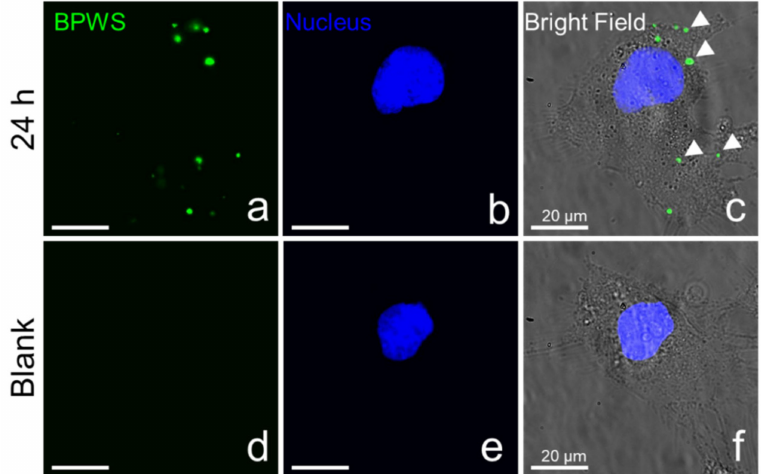
Figure 6. Fluorescence images of cancer cell permeability and intracellular uptake from the ( a ) NHS-Fluorescein (FITC) fluorescence signal, ( b ) 4 (cid:48) ,6-diamidino-2-phenylindole (DAPI) fluorescence signal, and ( c ) bright field merged image from FITC labeled biphenyl wrinkled mesoporous silica (FITC-BPWS) treated cells. Images ( d ) FITC fluorescence signal, ( e ) DAPI fluorescence signal, and ( f ) bright field merged image are from phosphate bu ff er solution (PBS)-treated cells.